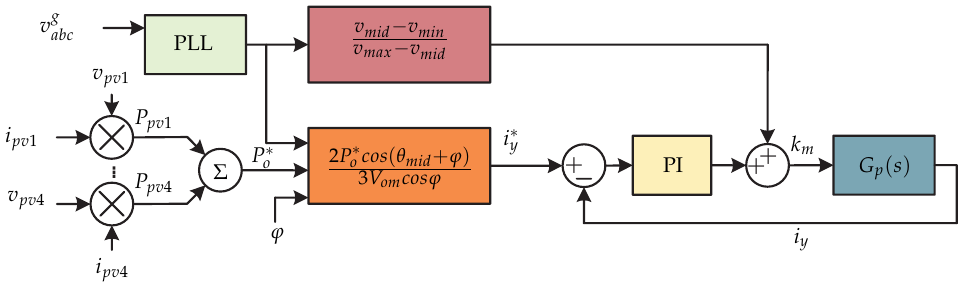
Figure 32. Control strategy proposed in [66].